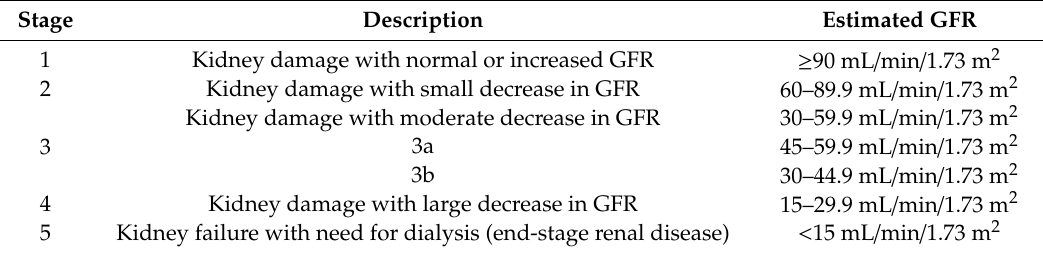
Table 1. The Stages of chronic kidney disease